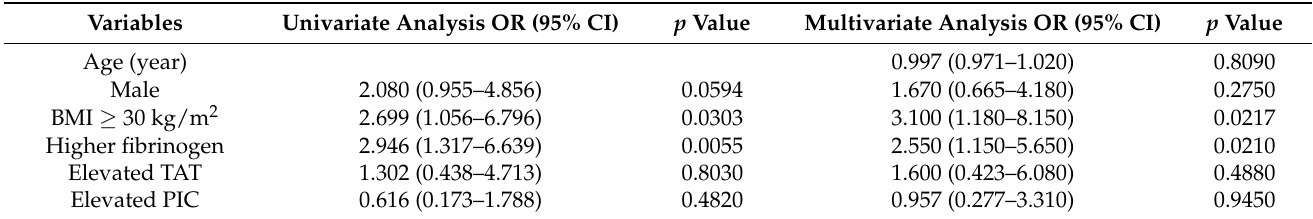
Table 6. Factors associated with severe respiratory failure in subjects with elevated